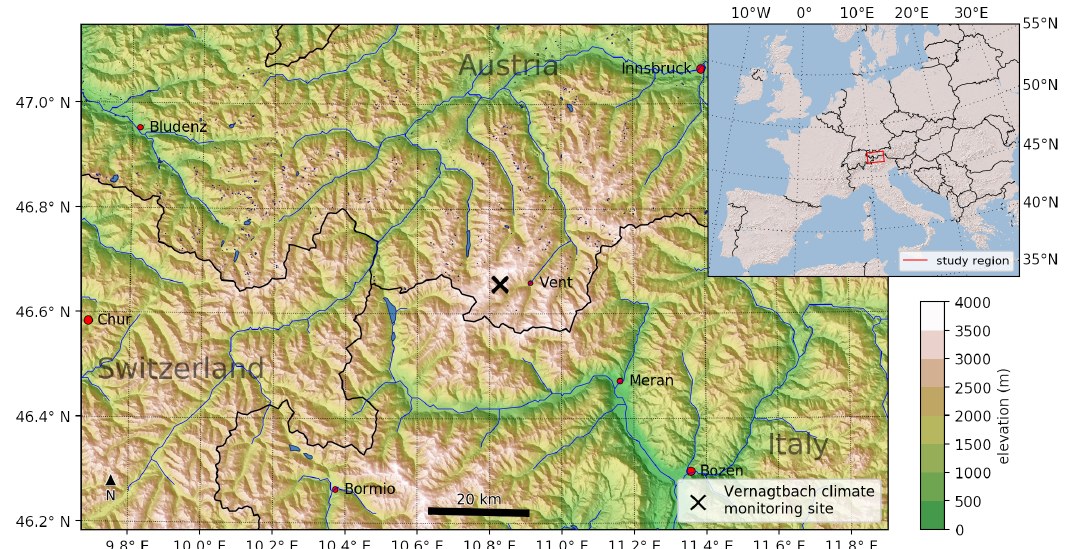
Figure 1. Situation of the Vernagtbach climate monitoring site within the European